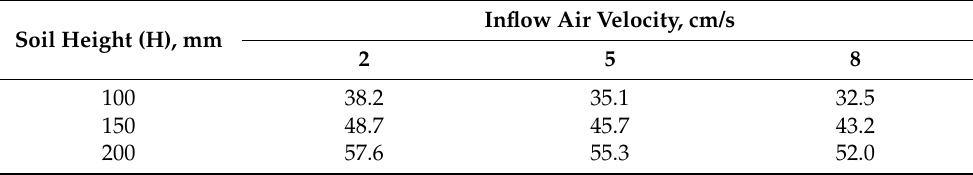
Table 4. Average value of PM 2.5 reduction rate for the soil height and the inflow air velocity. Soil Height (H),